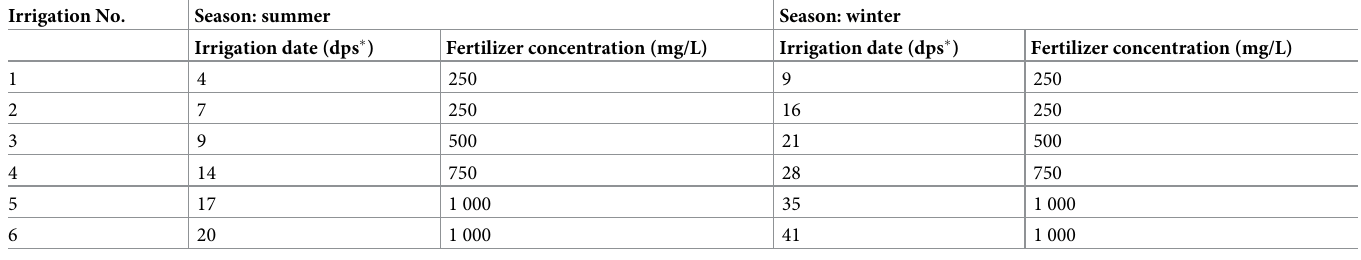
Table 1. The irrigation frequency and fertilizer concentrations of cucumber plug seedlings cultivated in an ebb-and-flow system in summer and winter. Irrigation